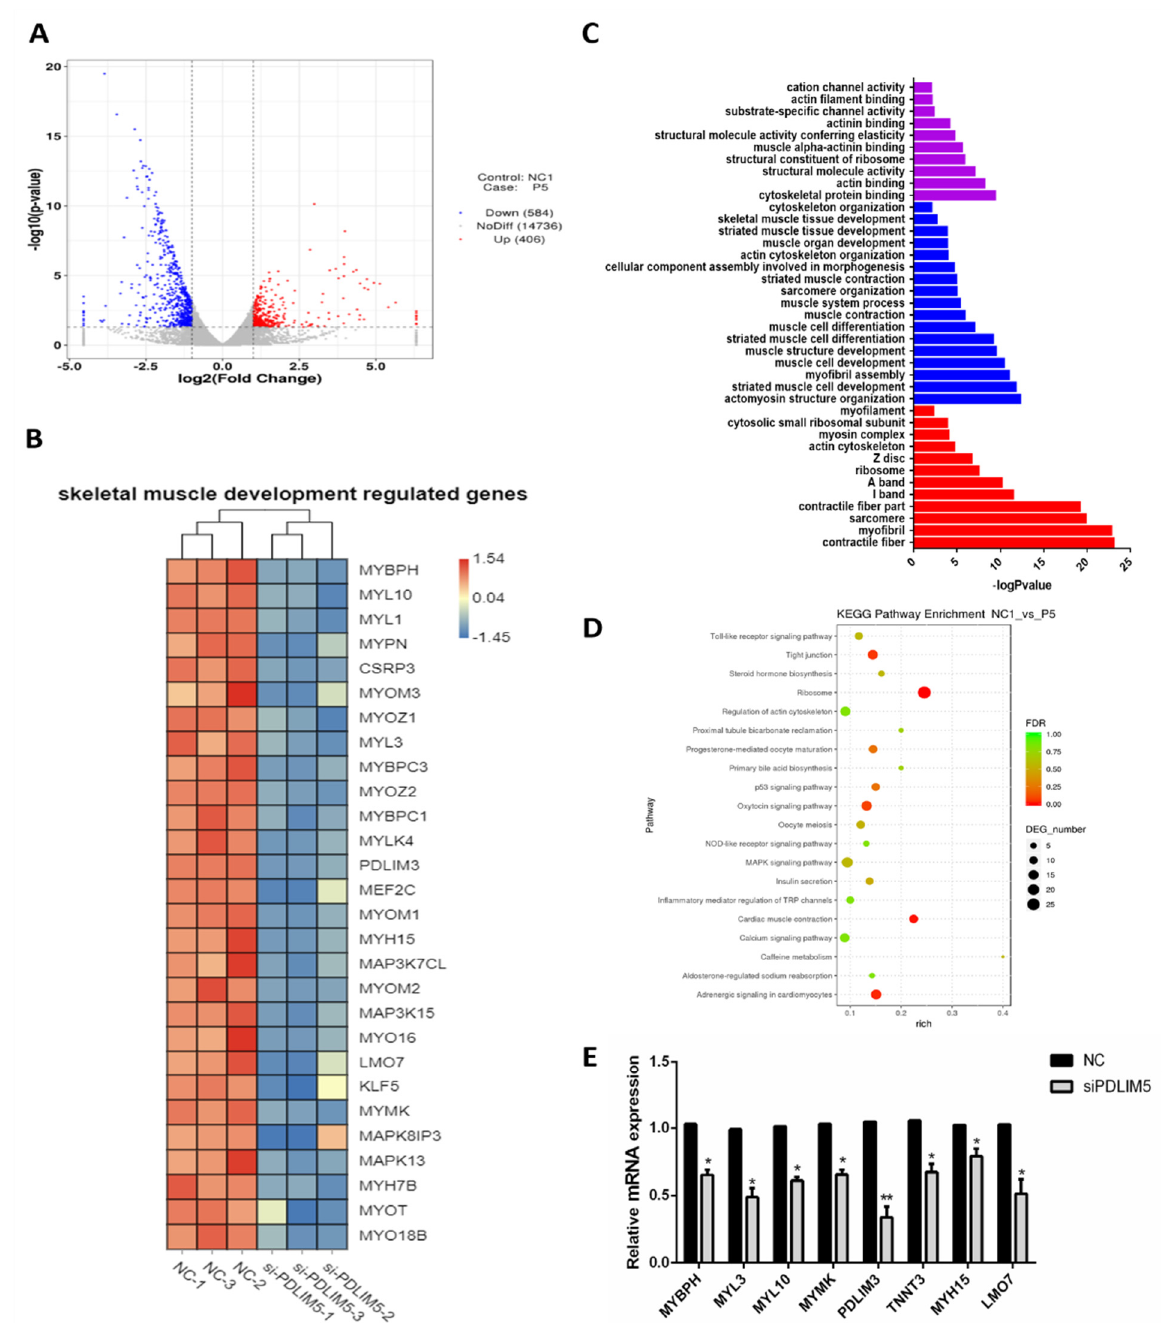
Figure 4. Interfering with transcriptome sequencing of si-PDLIM5 and negative control cells. ( A ) Volcano plot of statistically up-regulated or down-regulated genes after transcriptome analysis. ( B ) A heat map obtained by clustering analysis of differentially expressed genes that related to muscle development. ( C ) Analysis of differentially expressed genes by GO enrichment. ( D ) Analysis of the related pathways by KEGG enrichment. ( E ) Verification of mRNA expression of muscle development-related genes in transfected si-PDLIM5 or control. * p < 0.05; ** p < 0.01 relative to NC (negative control) ( n = 9).